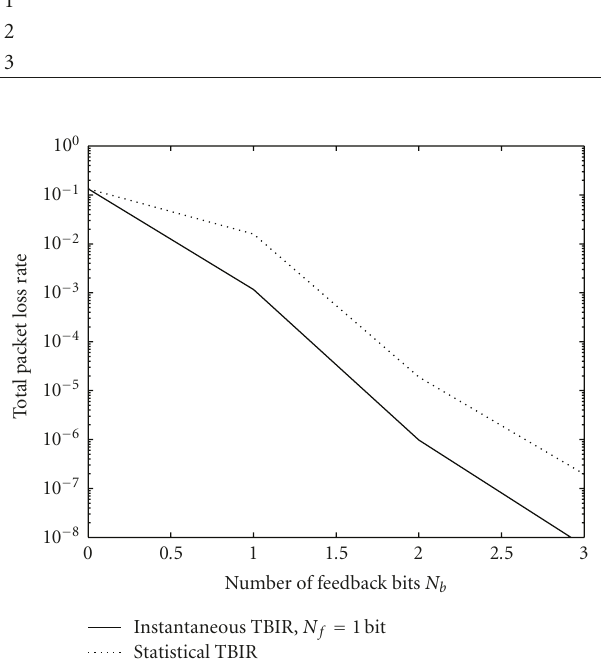
Figure 7: Variation of average packet loss with number of feedback bits is shown for statistical TBIR (dotted lines) and one bit of instantaneous TBIR (solid